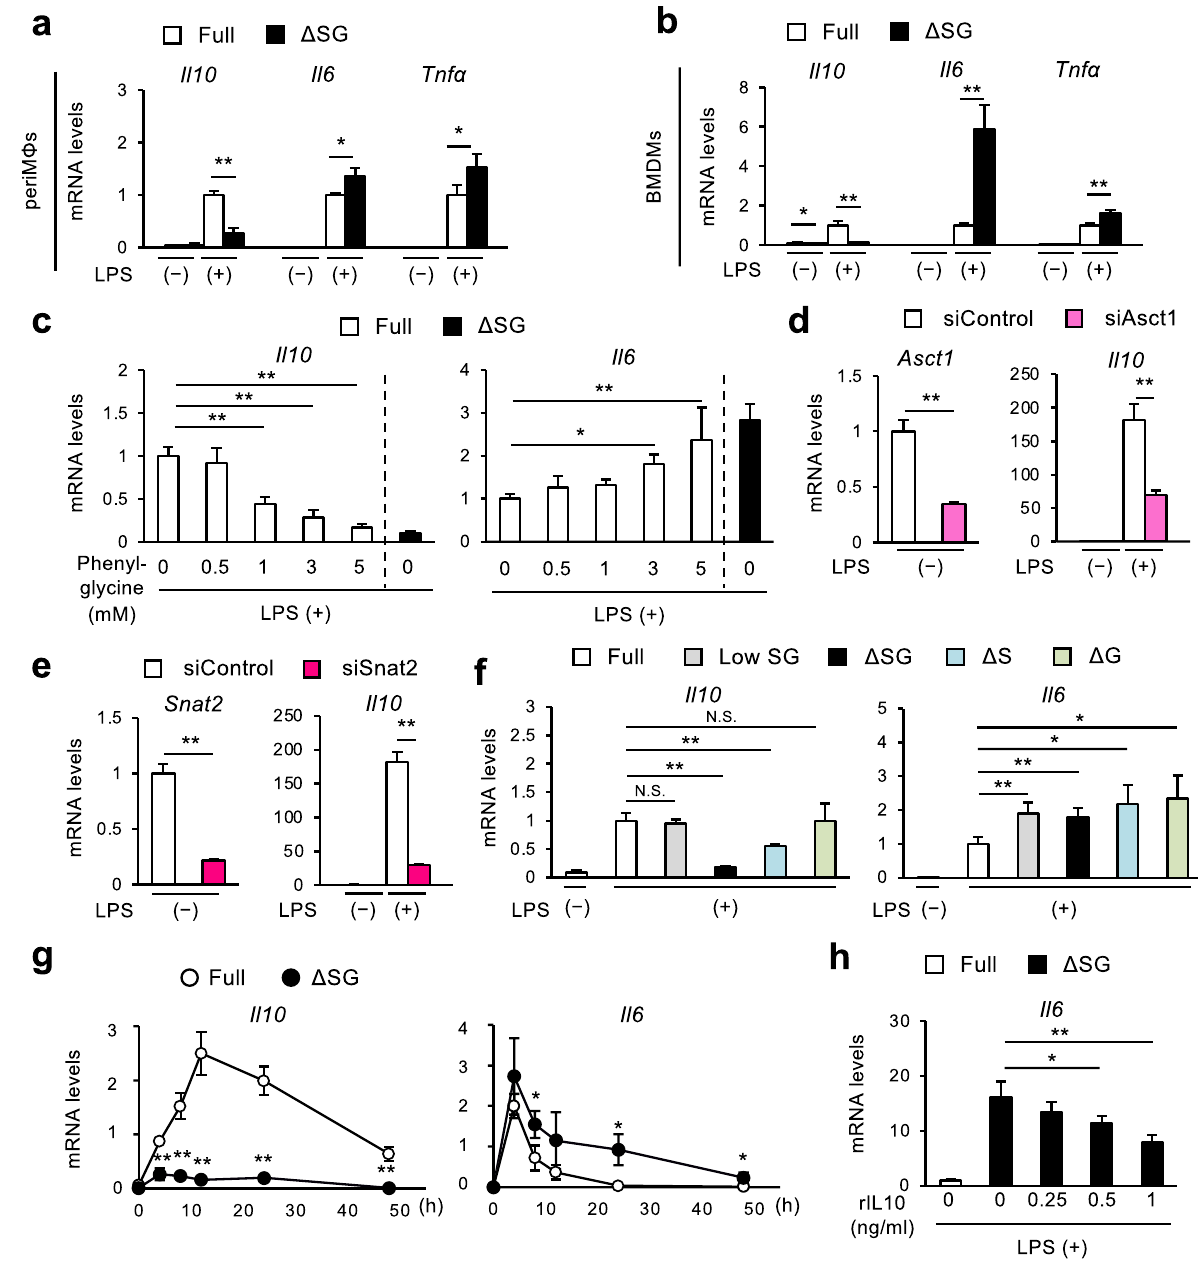
Figure 2. Serine and glycine deprivation results in aberrant cytokine expression in macrophages. ( a , b ) Gene expression of cytokines in periMΦs ( a ) and BMDMs ( b ). PeriMΦs and BMDMs were cultured in Full or ∆SG medium for 24 h, followed by stimulation with LPS (100 ng/ml) for 8 h and 24 h, respectively (n = 3–4). ( c ) Gene expression of Il10 and Il6 in BMDMs. BMDMs were cultured in Full or ∆SG medium with the indicated concentrations of 4-hydroxy-L-phenylglycine (an inhibitor of ASCT1 and ASCT2) for 24 h, followed by stimulation with LPS (100 ng/ml) for 8 h (n = 4). ( d , e ) Gene expression of Asct1 and Il10 (E) and of Snat2 and Il10 (F) in J774 macrophages transfected with siAsct1 ( e ), siSnat2 ( f ), and siControl were stimulated with LPS (100 ng/ml) for 24 h (n = 4). ( f ) Gene expression of Il10 and Il6 in BMDMs cultured in medium containing various levels of serine and glycine for 24 h, followed by stimulation with LPS (100 ng/ml) for 8 h. Full medium contains 400 µM serine and 400 µM glycine, Low SG medium contains 100 µM serine and 100 µM glycine, ∆SG medium contains neither serine nor glycine, ∆S medium contains no serine and 400 µM glycine, and ∆G medium contains 400 µM serine and no glycine, (n = 4). ( g ) Gene expression of Il10 and Il6 in BMDMs at before and 4, 8, 12, 24, and 48 h after LPS stimulation. BMDMs were cultured in Full or ∆SG medium for 24 h, followed by stimulation with LPS (100 ng/ml) for the indicated times (n = 4). ( h ) Gene expression of Il6 in BMDMs. BMDMs were cultured in Full or ∆SG medium for 24 h, treated with the indicated concentrations of recombinant IL10 (rIL10) for 4 h, and then stimulated with LPS (100 ng/ml) for 24 h (n = 3). Values are means ± 95% CI. Statistical analysis was performed unpaired t test ( a , b , d – f ) and Dunnett’s test ( c , g , h ) (compared to Full + phenylglycine 0 mM ( c ); ∆SG + rIL10 0 ng/ml ( g ); Full + LPS ( +) ( h )). * p < 0.05; ** p < 0.01. See also Supplementary Figs. S3 and